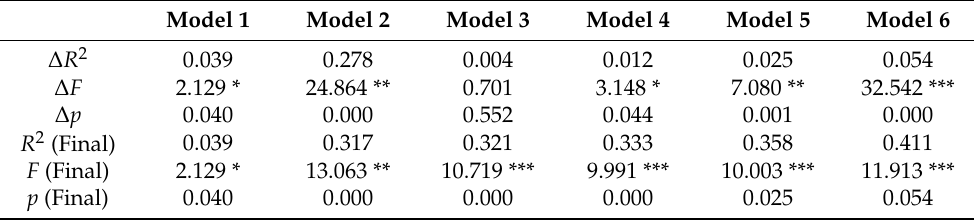
Table 3. Predictive effect of nutrition literacy on healthy eating behavior.